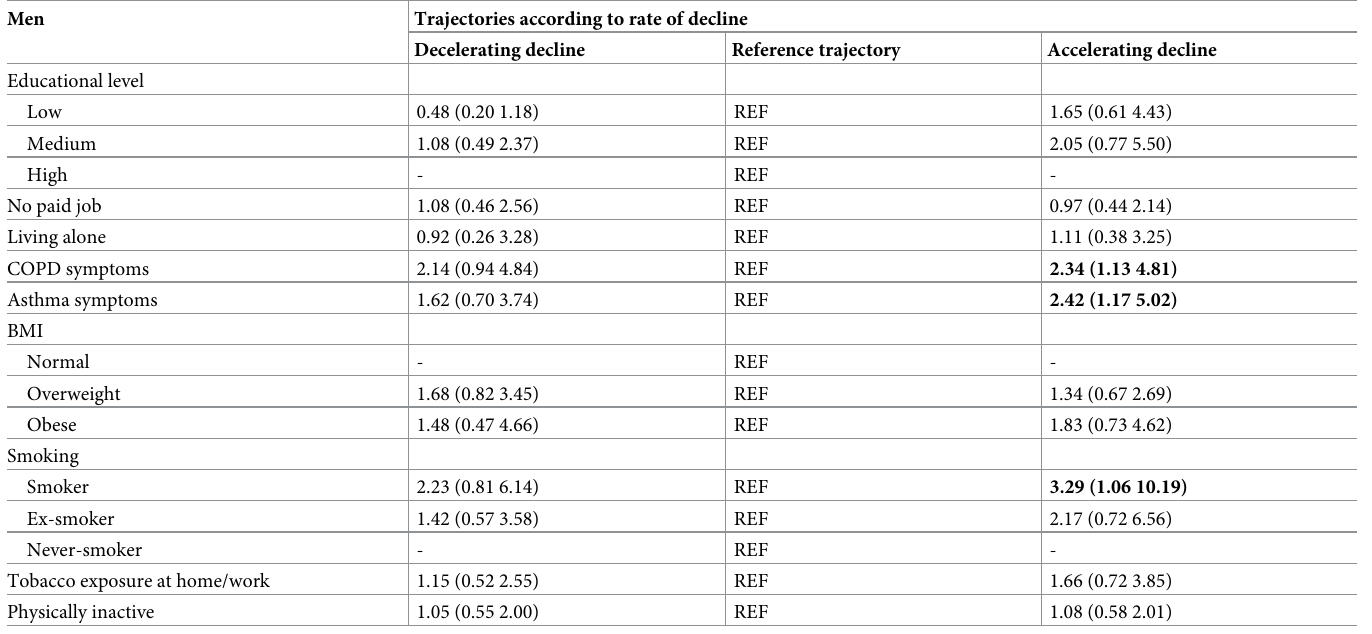
Table 3. Baseline sociodemographic and lifestyle determinants of the trajectories for men compared to the most common FEV 1 trajectory (reference trajectory).